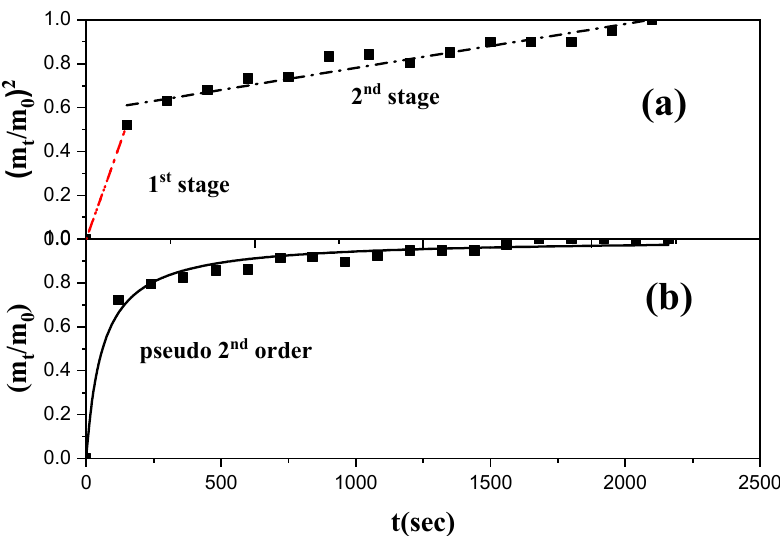
Figure 10. Desorption kinetics of controlled TO release from LDPE/15TO@NZ film: ( a ) linearized mode, Equation (7), and ( b ) pseudo-second-order sorption kinetic model, Equation (8).